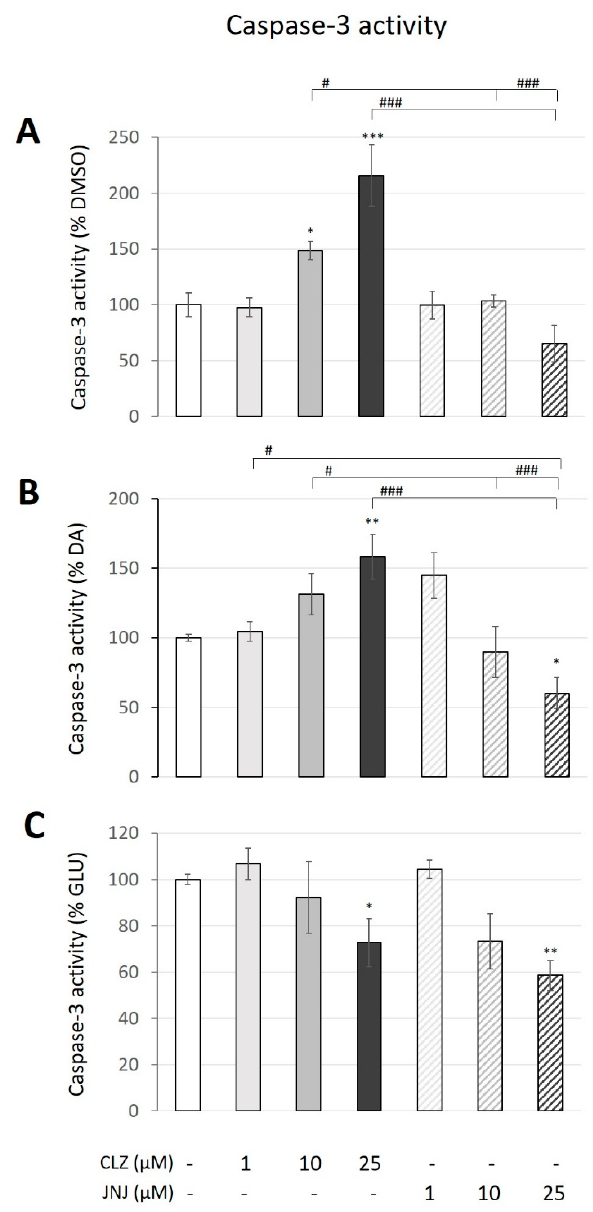
Figure 2. Effects of different concentrations (1, 10 and 25 µ M) of clozapine (CLZ) and JNJ-46356479 (JNJ) alone ( A ), in combination with dopamine (DA) at 200 µ M ( B ) and with glutamate (GLU) at 160 mM ( C ) on SK-N-SH caspase 3 activity after 24 h as measured by fluorometric assays. The values represent percentages of the control (DMSO-treated), DA-treated or GLU-treated cells and are expressed as means ± S.E.M (n = 3). Two-way ANOVA was performed to assess the drug treatment and concentration effect, and Bonferroni’s post hoc test was used for pair comparisons. * p ≤ 0.05, ** p ≤ 0.01, *** p ≤ 0.001 vs. control. # p ≤ 0.05, ### p ≤ 0.001 included in square brackets indicate comparisons between CLZ and JNJ.